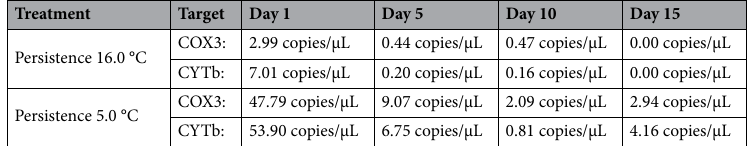
Table 2. Average Somatochlora hineana eDNA concentrations—persistence experiment.